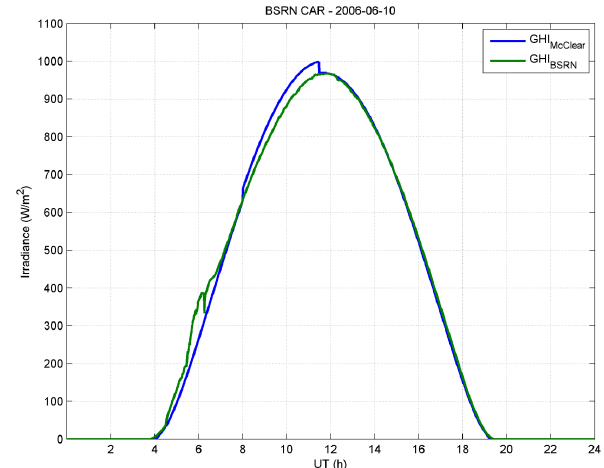
Fig. 2. Profiles of the 1min global irradiance measured (BSRN) and estimated on 10 June 2006 at Carpentras in the southeast of France as an example of a rare failure case of the aerosol type selection scheme. GHI: global horizontal